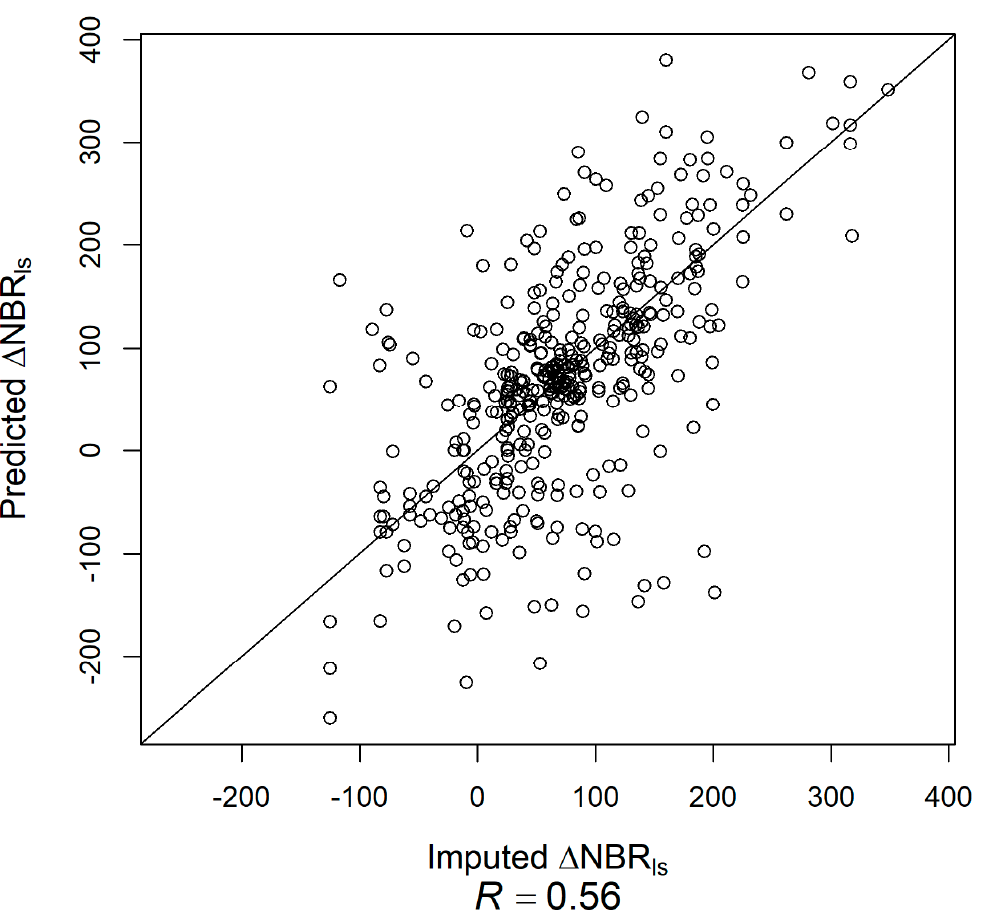
Figure 4. Imputed versus observed ∆ NBR ls values from internal validation, reported by the Random Forest based k-nearest neighbors (k-NN) algorithm to predict ‘Candidatus Phytoplasma pini’ defoliation levels for the southeastern Andalusia Pinus halepensis forests.